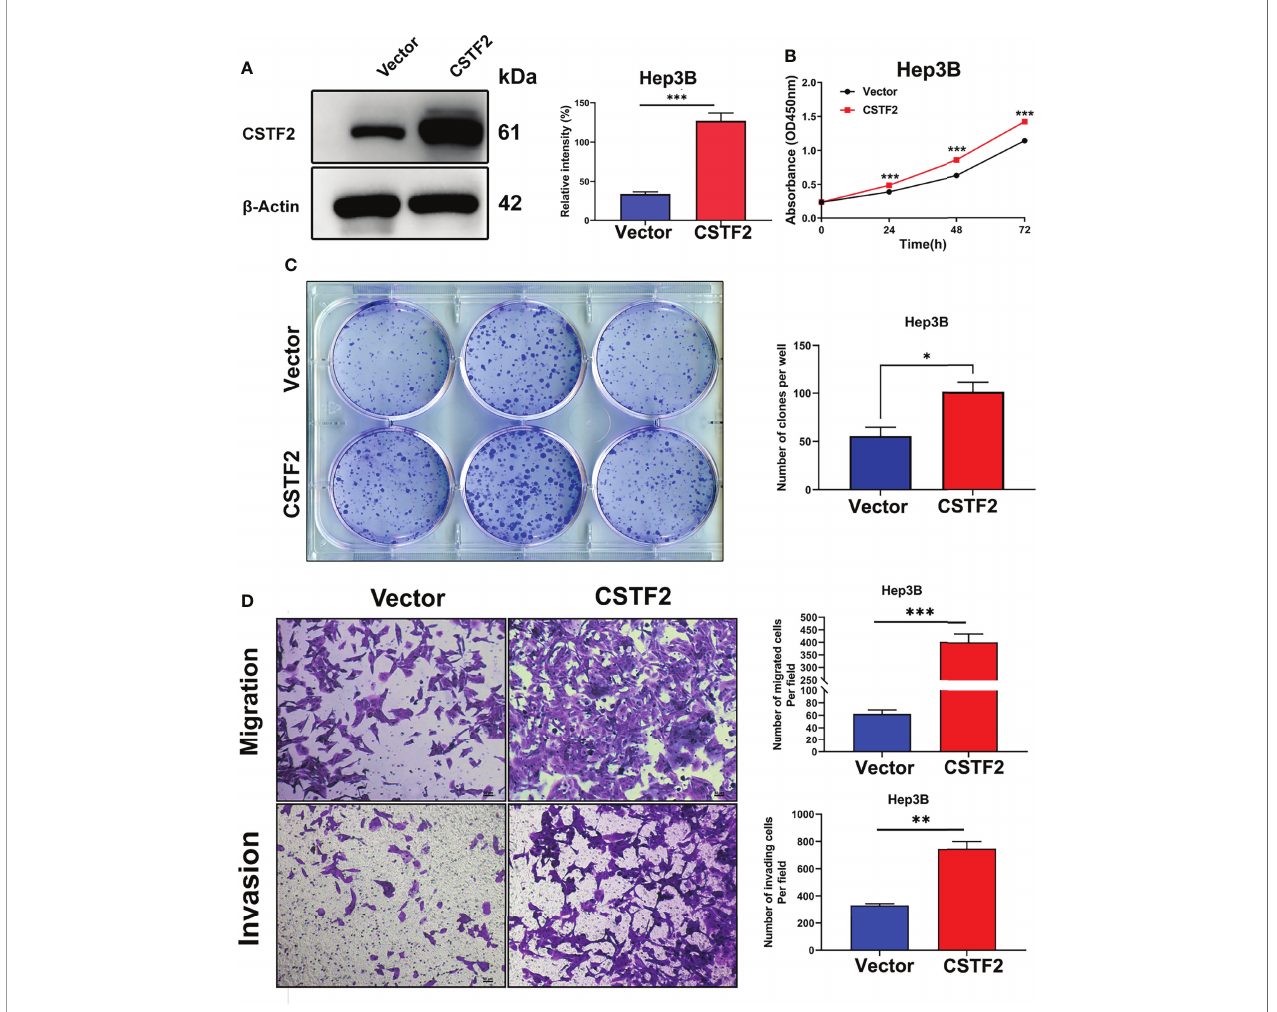
FIGURE 6 | Overexpression of CSTF2 promoted the cell proliferation, migration, and invasion of HCC cells in vitro . (A) The stable overexpression of CSTF2 in Hep3B cells was determined by Western blot (left panel) and the quali fi cation of the relative intensity of CSTF2 protein levels (right panel). (B) CCK-8 assay of the cell proliferation rate of the overexpression of CSTF2 Hep3B cells. (C) Colony-forming assay of the overexpression of CSTF2 Hep3B cells (left panel) and the quali fi cation of the number of colonies formed (right panel). (D) The migration and invasion were measured in the overexpression of CSTF2 Hep3B cells by the Transwell assay (left panel) and the quali fi cation of migrated cells and invading cells per fi eld (right panel). CSTF2 represents the overexpression of CSTF2. An empty vector was used as control. Scale bar, 50 m m. * r < 0.05, ** r < 0.01, *** r < 0.001 compared to the